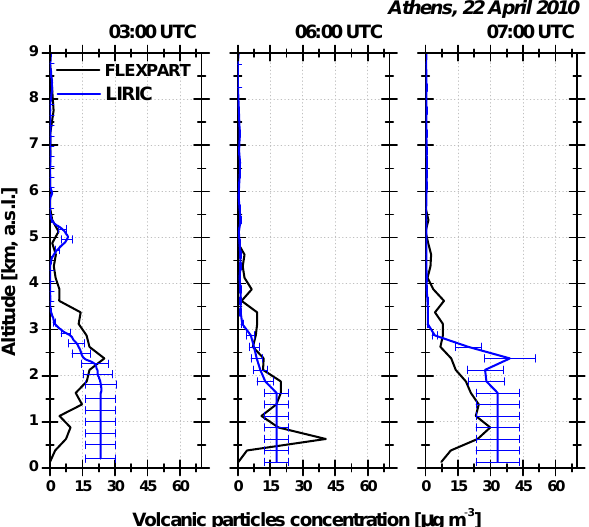
Fig. 6. Comparison of volcanic aerosol concentrations (in µgm − 3 ) retrieved by LIRIC and simulated by FLEXPART on 22 April 2010 over Athens at 03:00 (left), 06:00 (middle) and 07:00UTC (right).